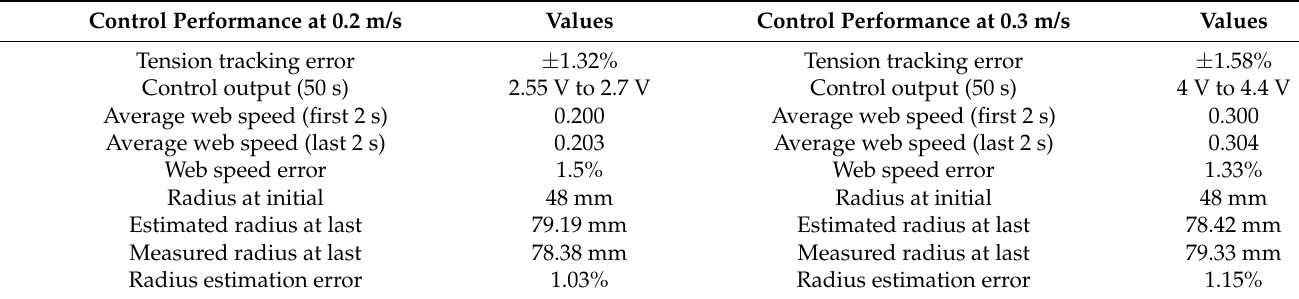
Figure 10. The control performance of the velocity loop is validated at 0.1 m/s of the web speed: ( a ) the web speed measured by the incremental rotary encoder and ( b ) the estimated radius of the rewinder. Table 1. Tension and velocity control performance at different web speeds ( T ref : 38 N, V ref : 0.2 and 0.3